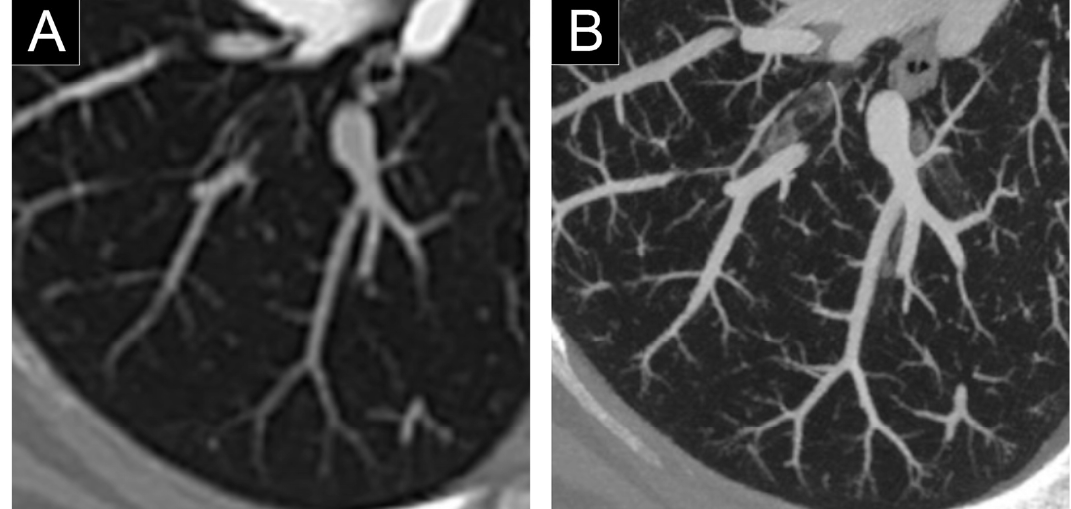
Figure 10. Comparison of the distal arterial pulmonary tree with a dual-layer EID-CT (iQon, Philips, Haifa, lsrael; ( A )) and a clinical prototype PCD-CT (Philips; ( B )) and) after injection of iodinated contrast agent. The improvement in quality is visible, notably of the distal vessel lumen and calipers that are depicted until the pleural space.